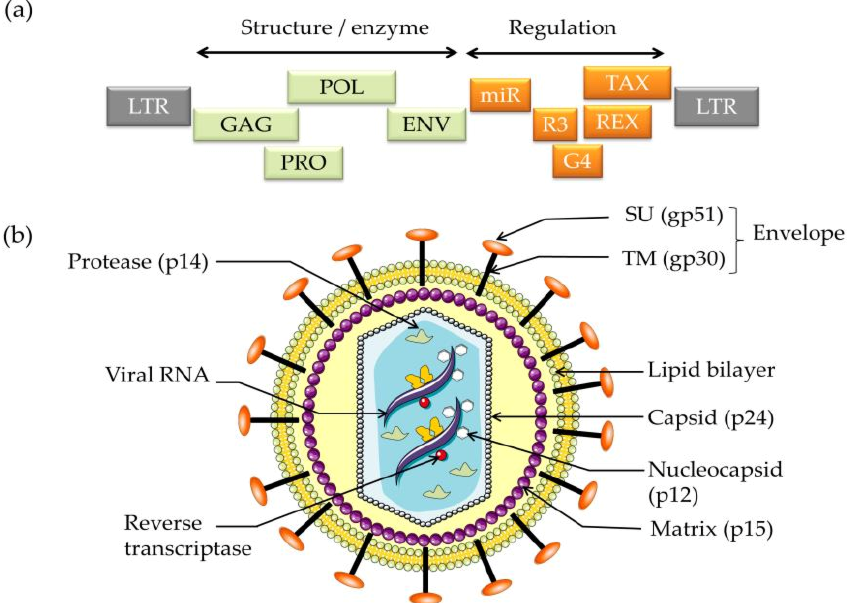
Figure 1. Schematic structure of ( a ) the bovine leukaemia virus (BLV) genome ( b ) the viral particle [68].